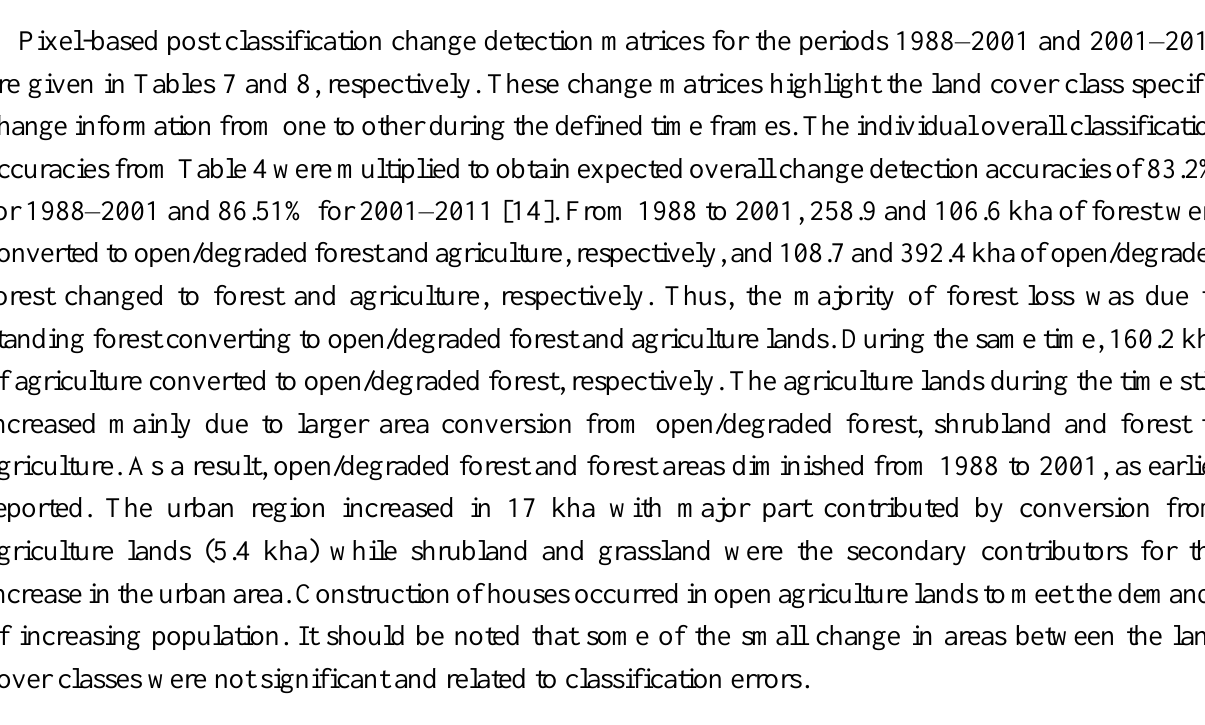
Table 7. Matrices for land cover changes (kha) from 1988 to